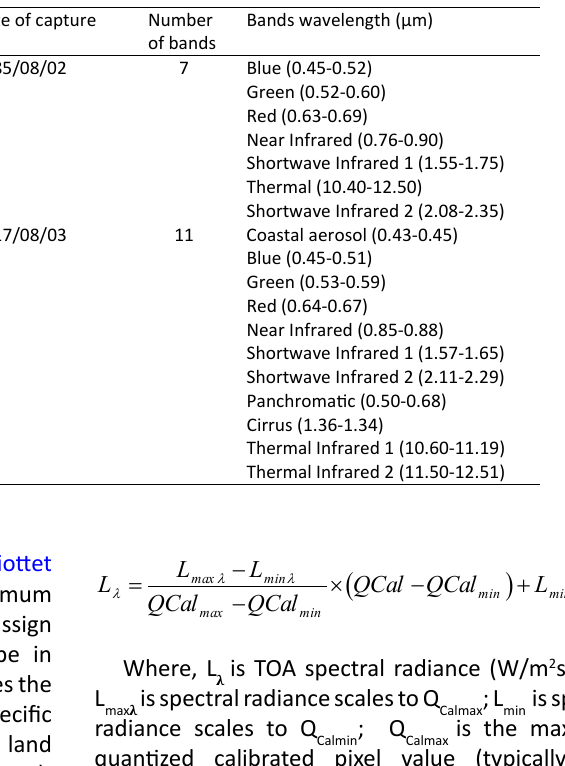
Table 1: Characteris (cid:415) cs of selected satellite images Table 1. Characteristics of selected satellite